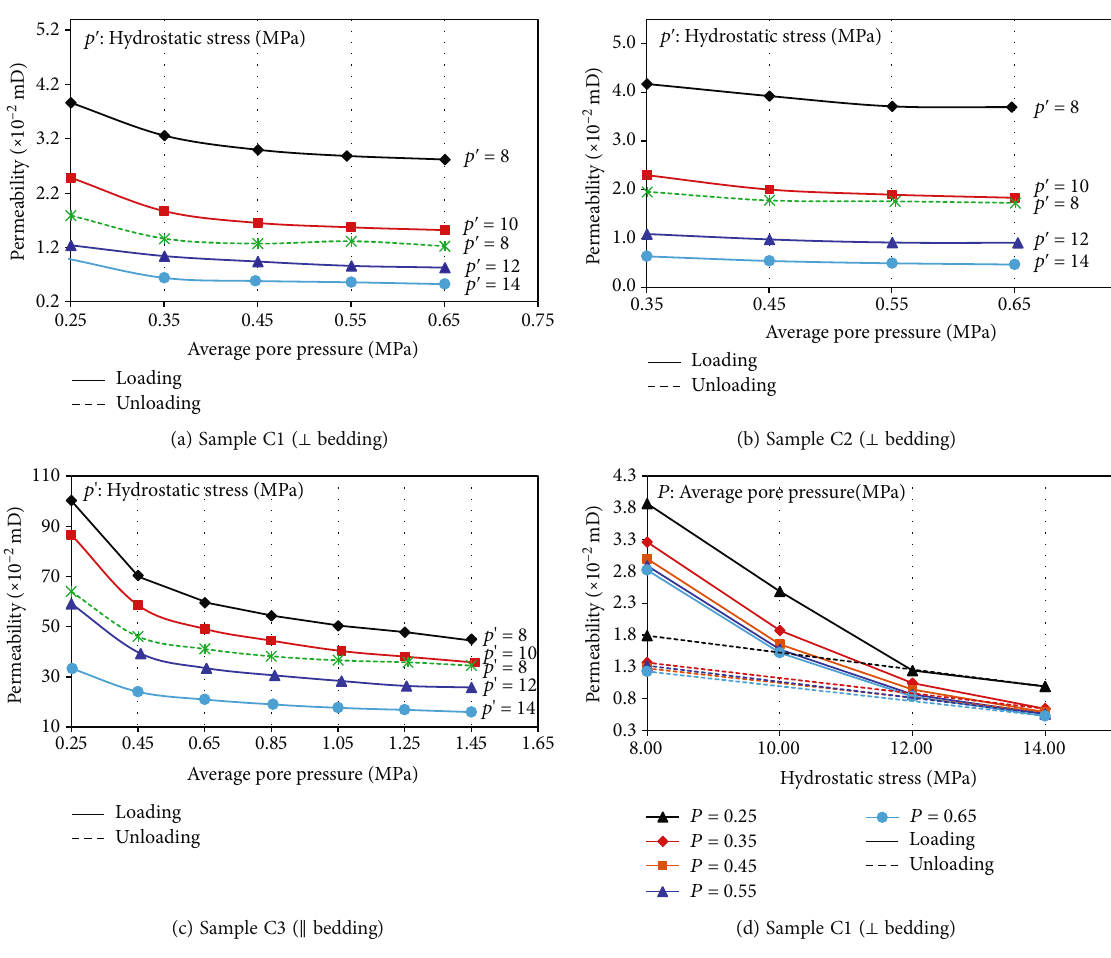
Figure 1: The permeability test results of coal samples under hydrostatic stresses.